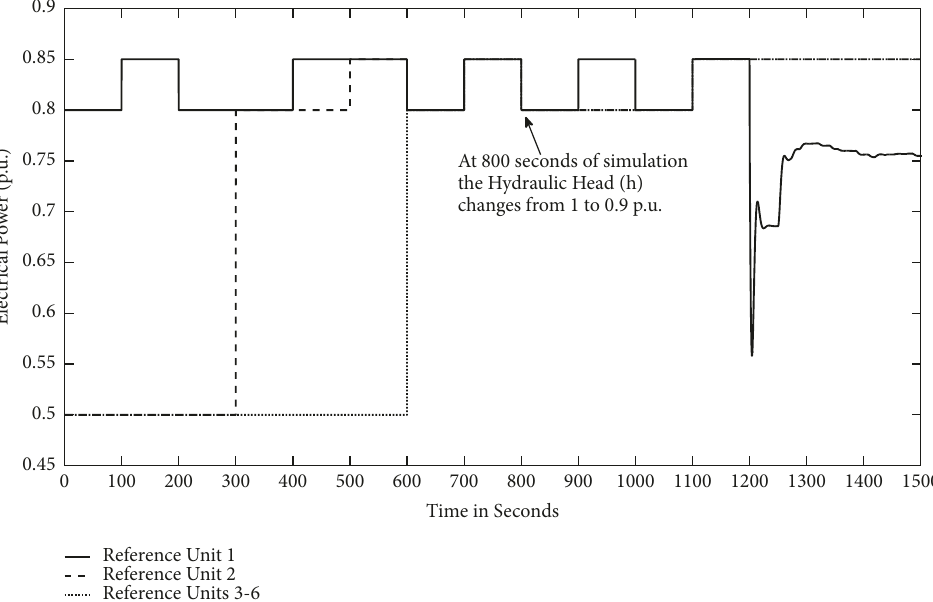
Figure 9: References used to simulate the hydropower plant.